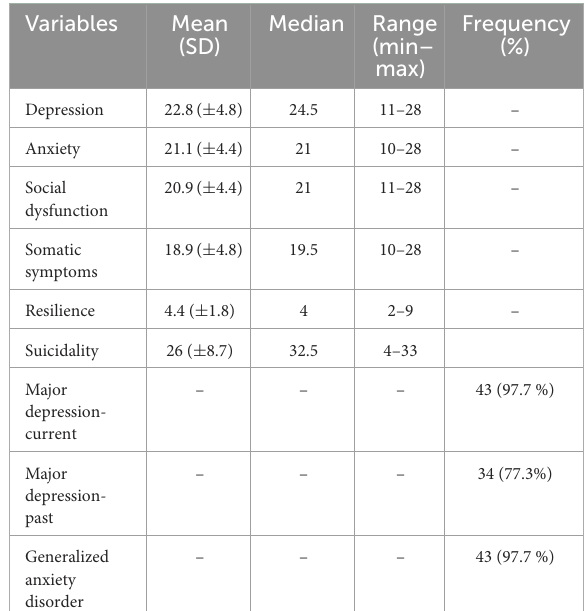
TABLE 2 Summative scores and frequencies of major variables.